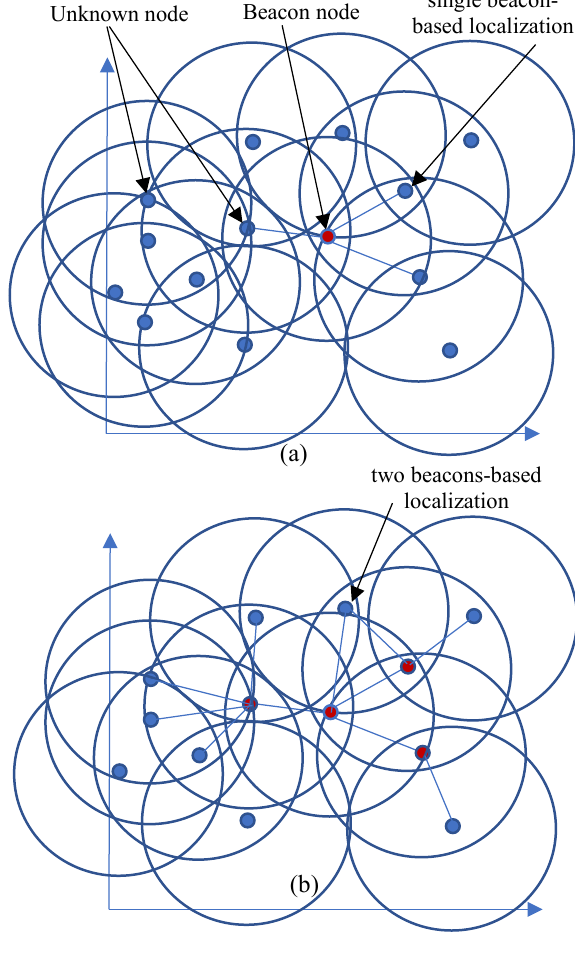
Beacon node Unknown